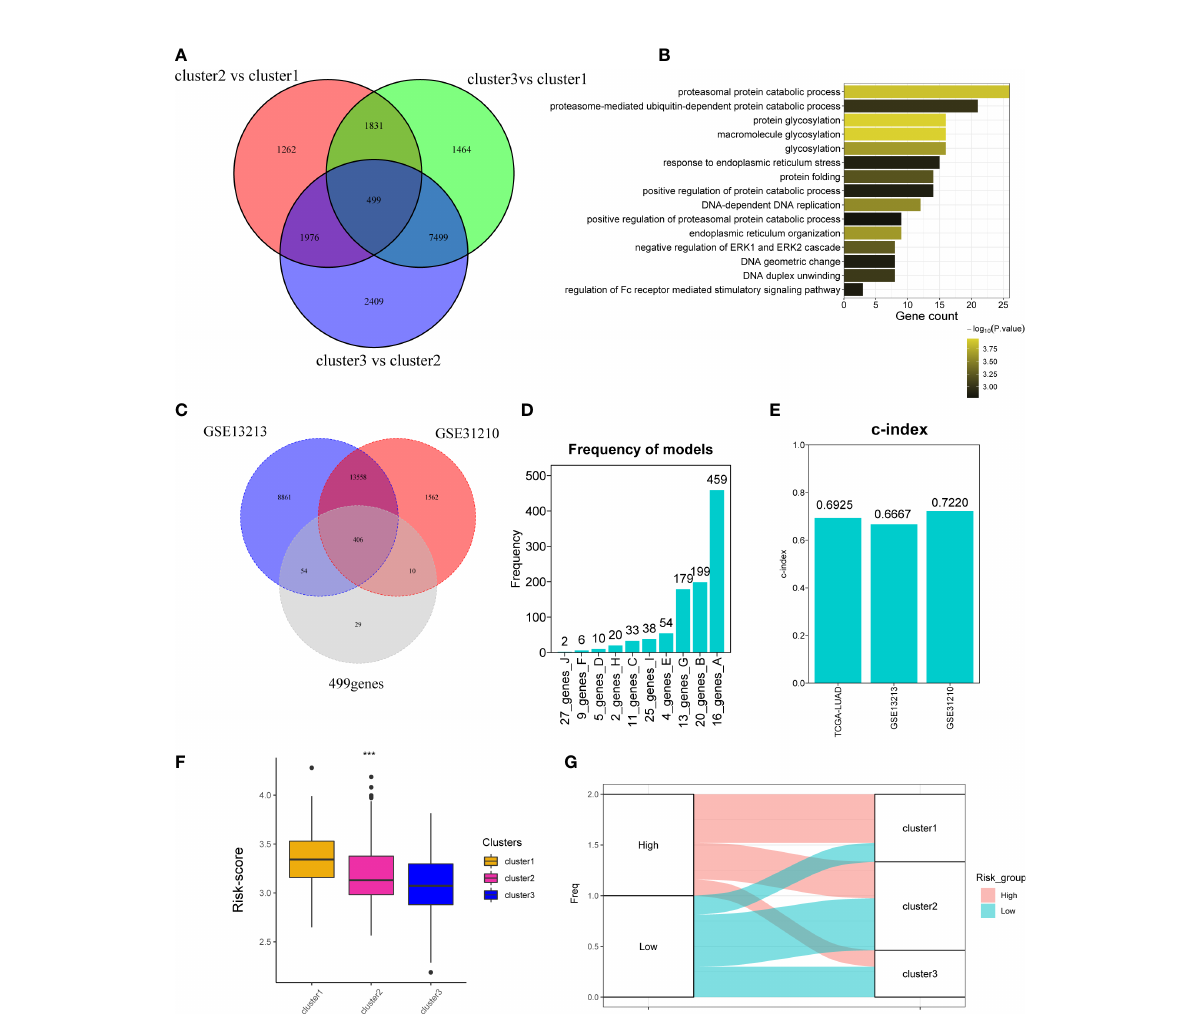
FIGURE 4 Development of cuproptosis-associated risk score. (A) Venn plot shows the differentially expressed genes called as cuproptosis phenotype- related genes. (B) GO function of differentially expressed genes. (C) Venn plot shows the overlapped genes of GSE13213, GSE31210, and 499 differentially expressed genes detected in TCGA-LUAD cohort. (D) Frequency models calculating the gene models. (E) Bar plot shows the c- index of two datasets. (F) Boxplot shows the risk_score of three clusters. (G) The distribution of three clusters in the high- and low-risk groups. *P < 0.05; **P < 0.01; ***P <